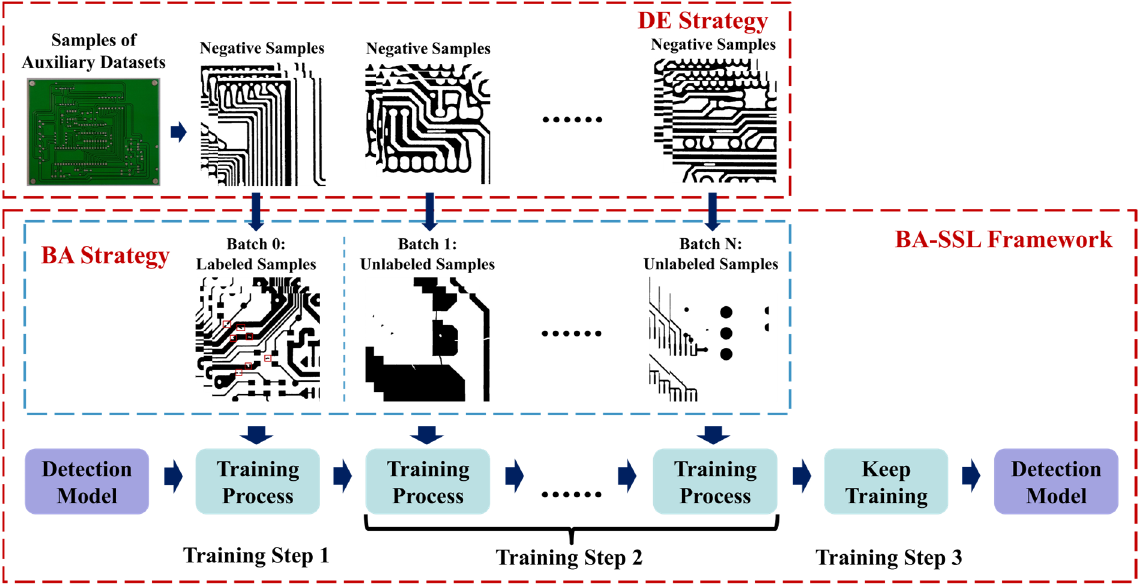
Figure 2. Training process of proposed DE-SSD